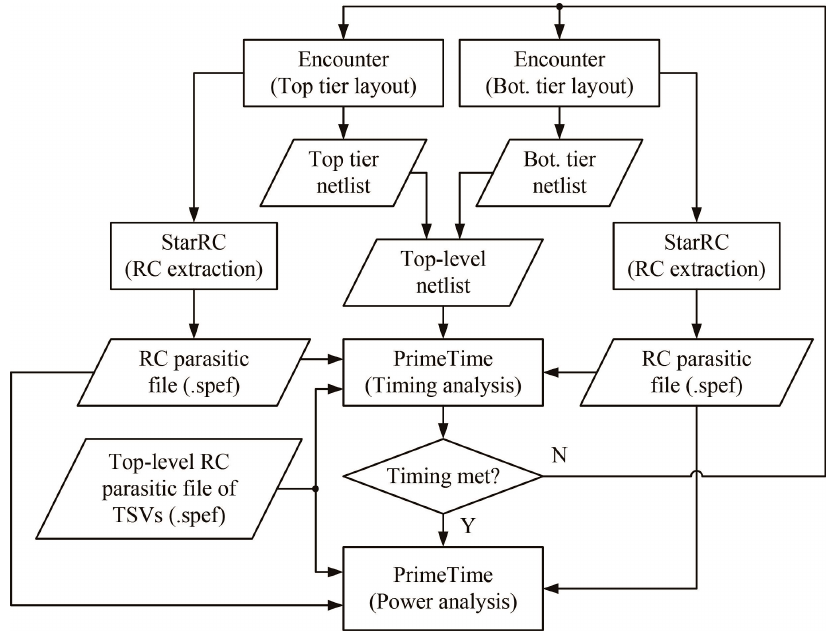
Figure 9. Overall flow of the power and timing analyses for a 3D IC.